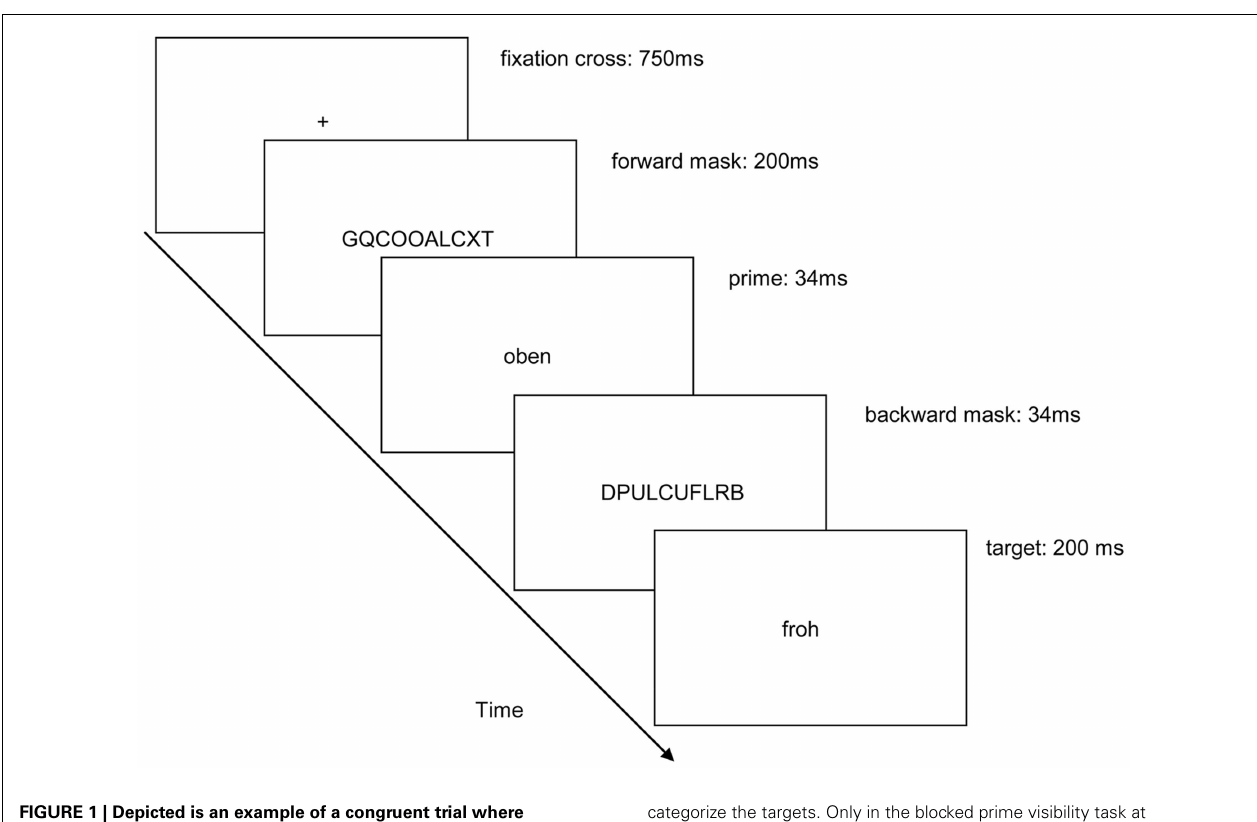
FIGURE 1 | Depicted is an example of a congruent trial where a spatial up-prime, here: “ oben ” ( on top ), preceded a positive valence target, here: “ froh ” ( joyful ). The arrow depicts the direction of time. In the target-response blocks, participants had to